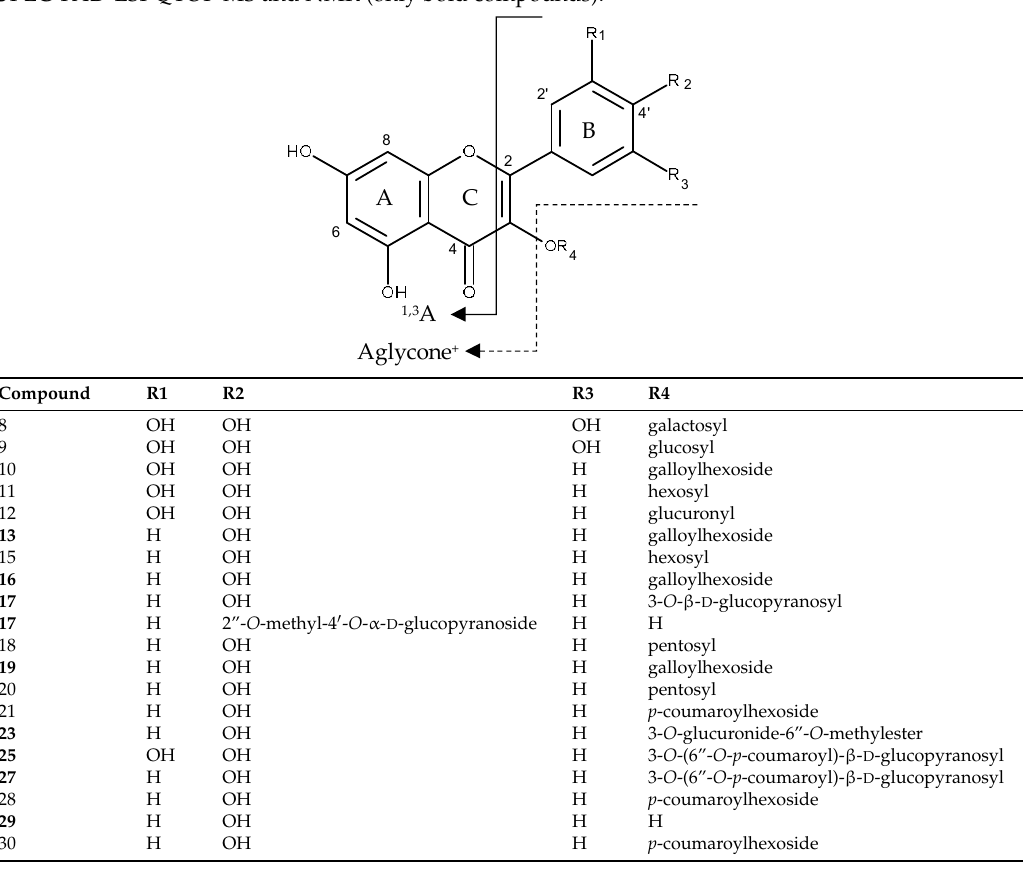
Table 3. Flavonol structures and substituents groups in T. pulchra flower extracts identified by UPLC-PAD-ESI-QTOF-MS and NMR (only bold compounds).